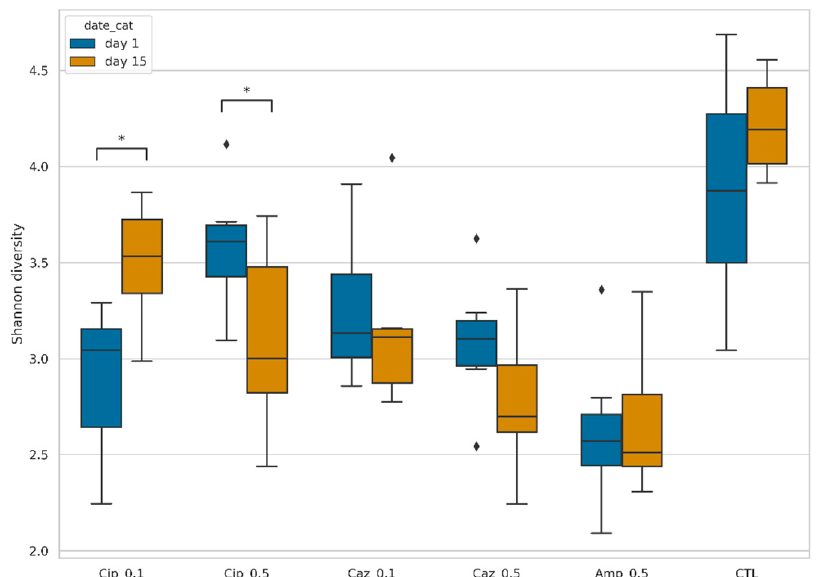
Figure 1. Shannon diversity of fecal samples, organized by sampling date and type of treatment. Box plots show the distribution of diversities in each group. Asterisks (*) show changes with p < 0.05 set as the limit for statistical significance. Diamonds ( ♦ ) shows the outlier values.